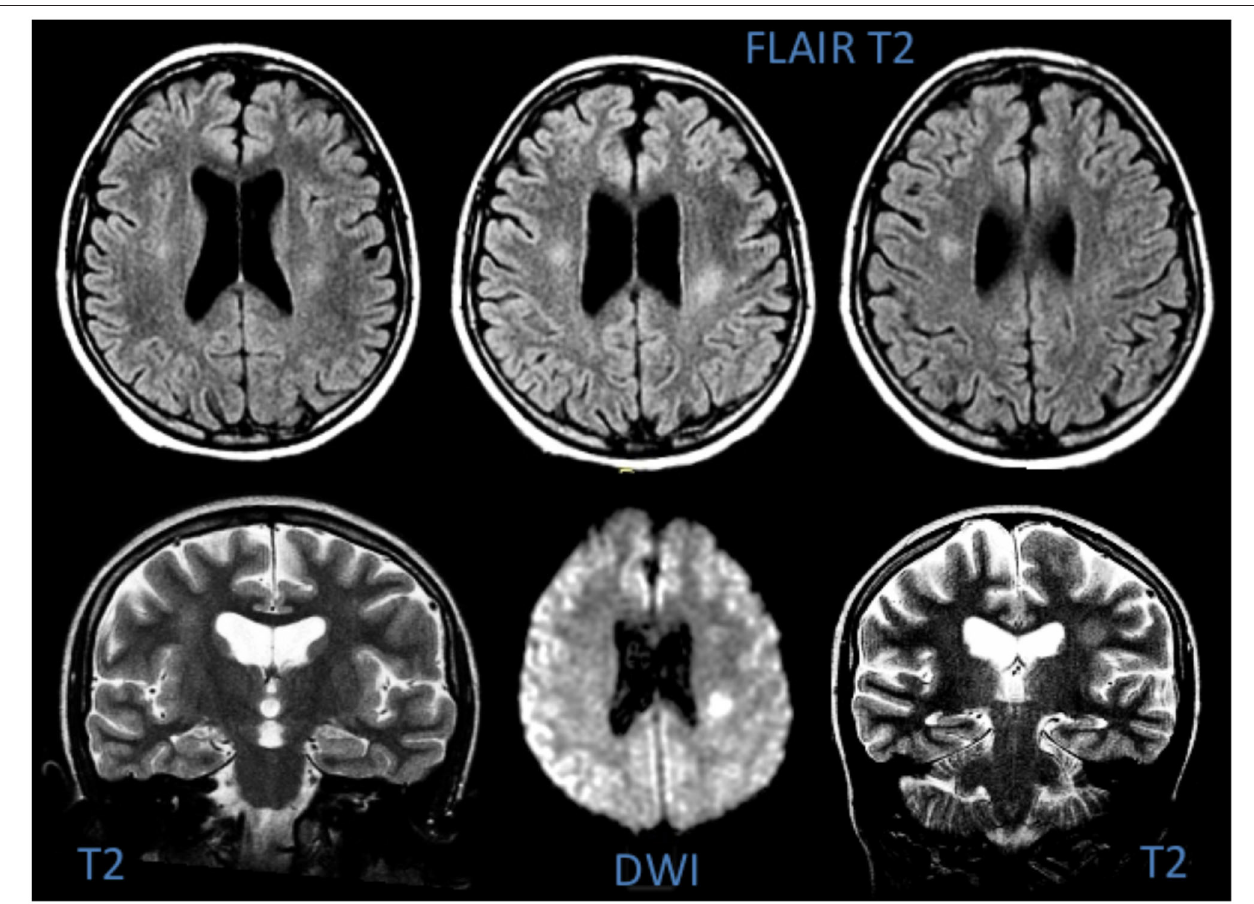
FIGURE 5 | MRI of Patient 6, showing hyperintensity of the deep white matter on T2-weighted images and signs of cytotoxic oedema in DWI.